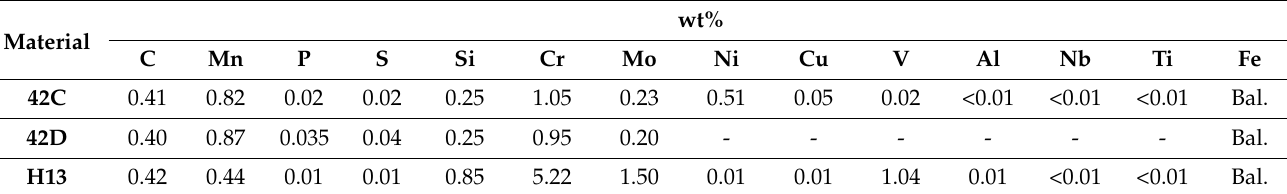
Table 1. Chemical composition of presented